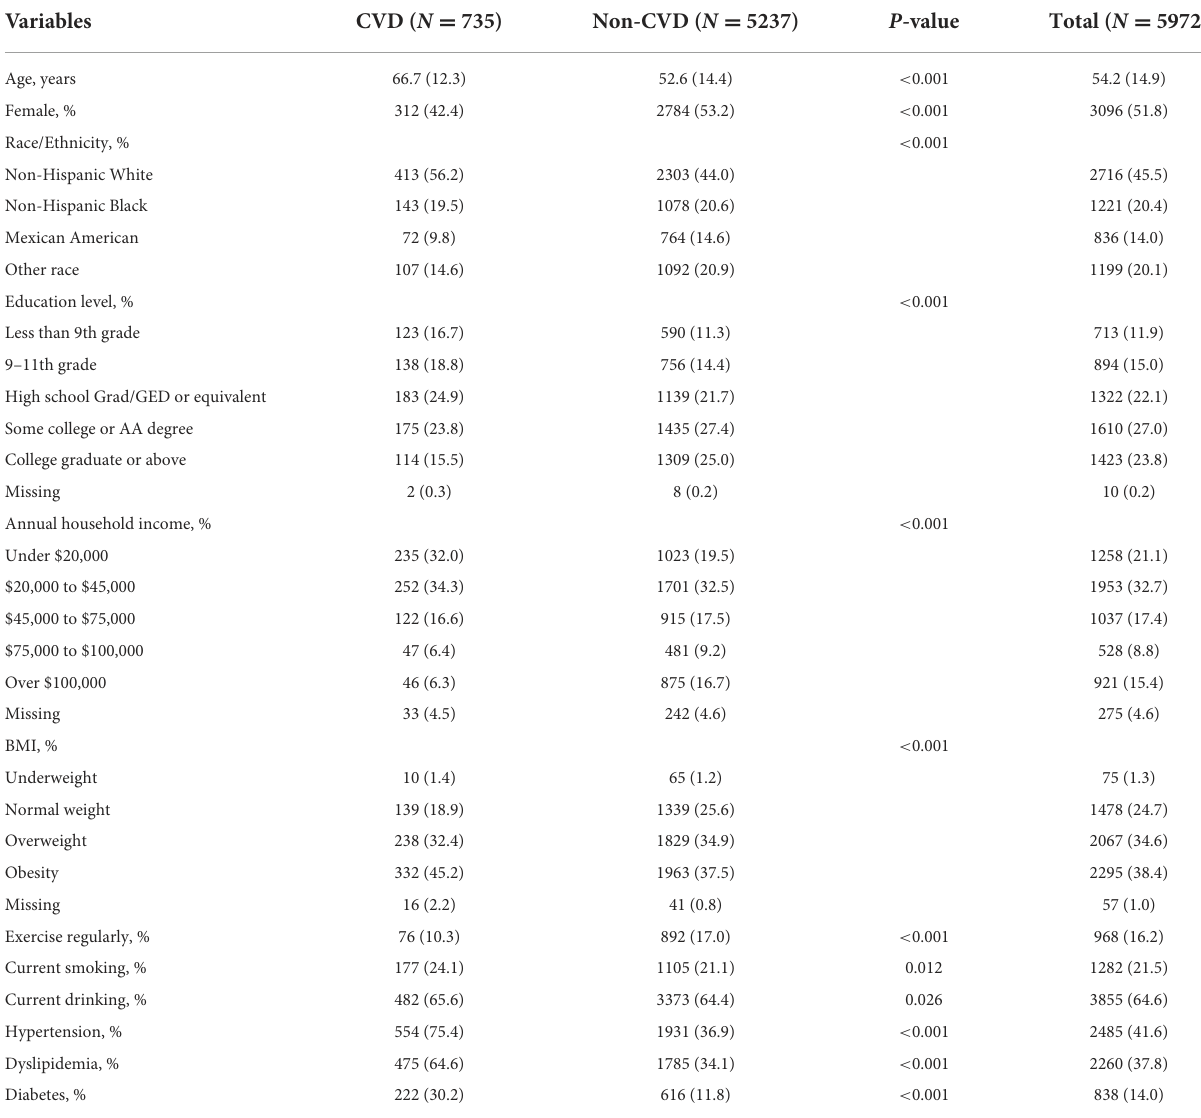
TABLE 1 Baseline characteristics of study variables by